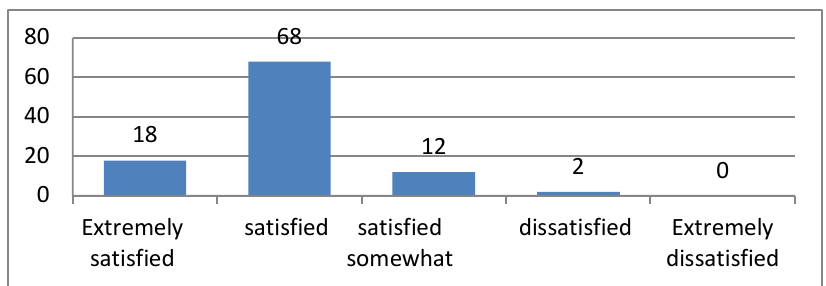
Figure3 : You have opportunities in your job to make full use of your skills and abilities.